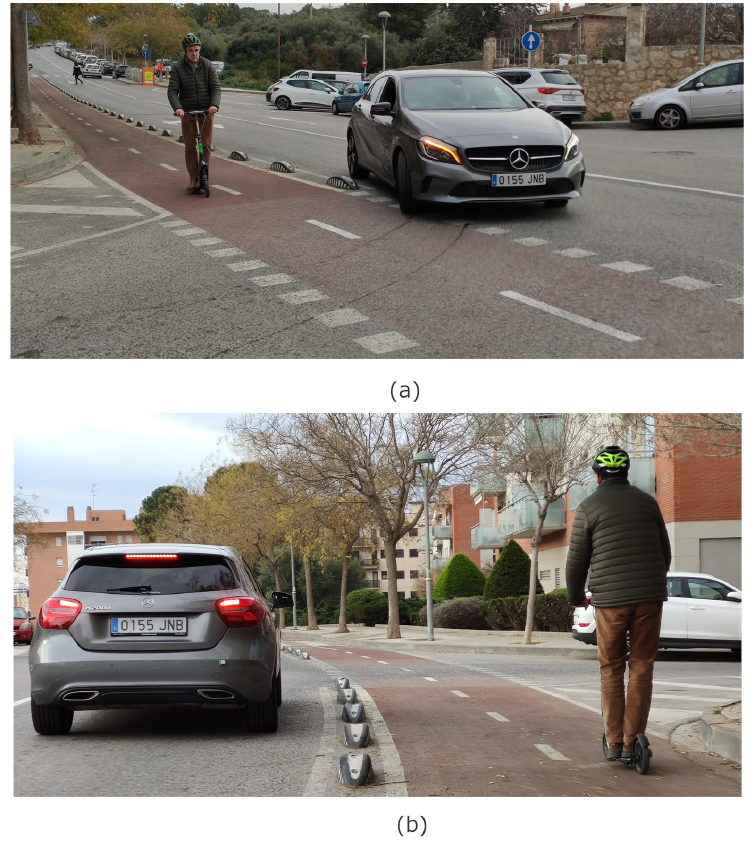
Figure 23. Photograph of the experimental setup ( a ) car changing direction; ( b ) turning car encroach- ing on the bike